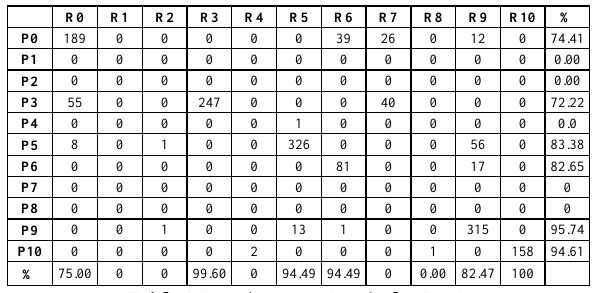
Table 3 Contingency Matrix for GLM